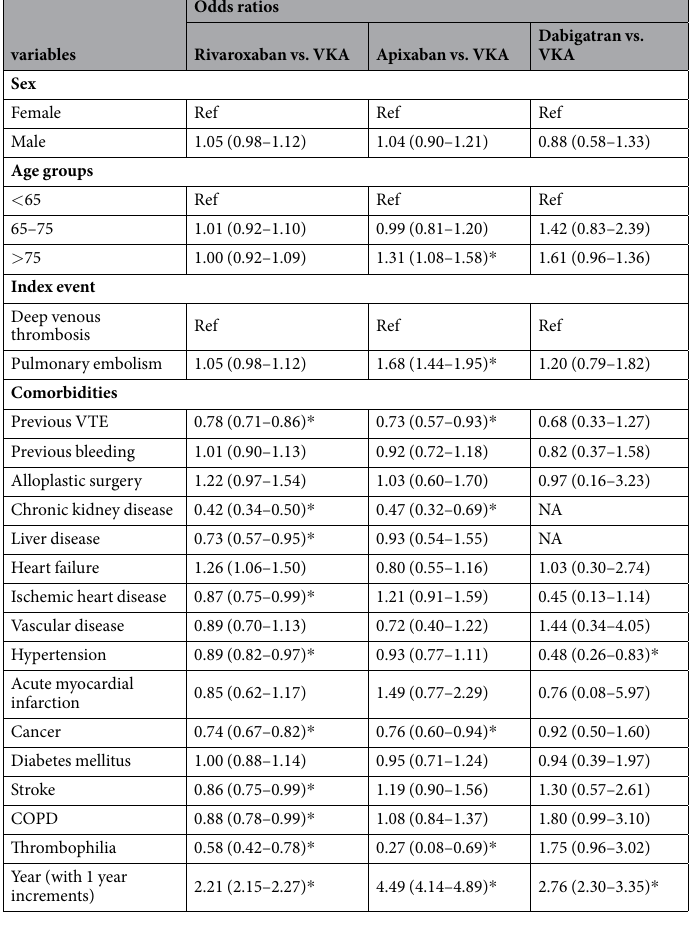
Table 2. Factors associated with initiation of rivaroxaban, apixaban, or dabigatran, vs. VKA in patients with VTE. Odds ratio below 1 indicates in favor of VKA and above 1 in favor of rivaroxaban, apixaban or dabigatran. * Indicates